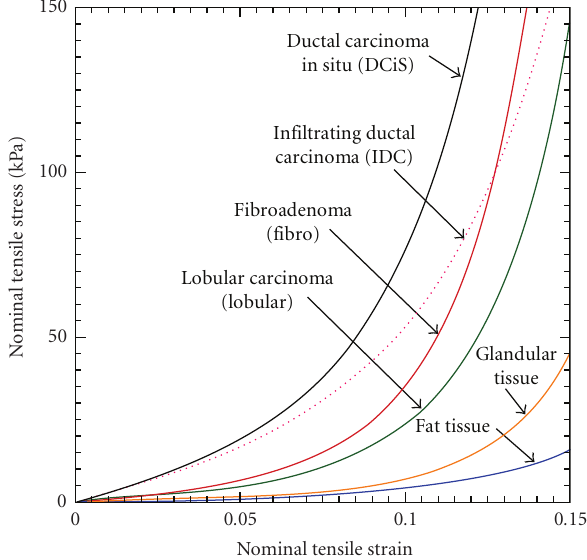
Figure 4: Nonlinear stress-strain curves for six breast tissues (fatty tissue, glandular tissue, lobular carcinoma, fibroadenoma, infiltrating ductal carcinoma, and ductal carcinoma in situ). (Figure redrawn based on [5] and (7)).